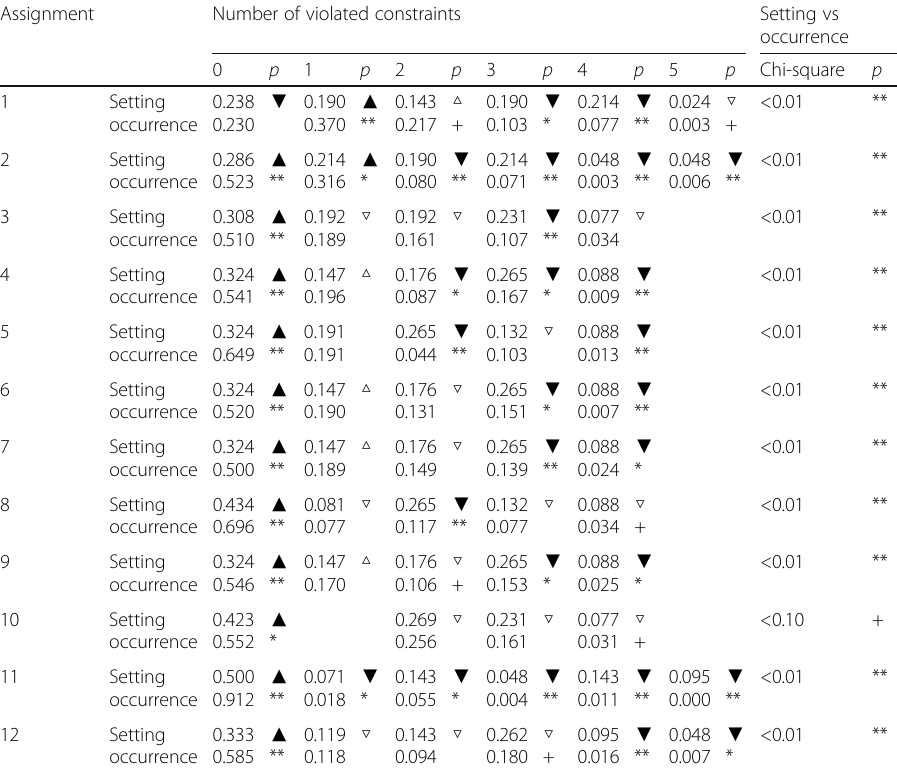
Table 3 Difference analysis between portions of number of states in assignment setting to its occurrence frequency Assignment Number of violated constraints Setting vs